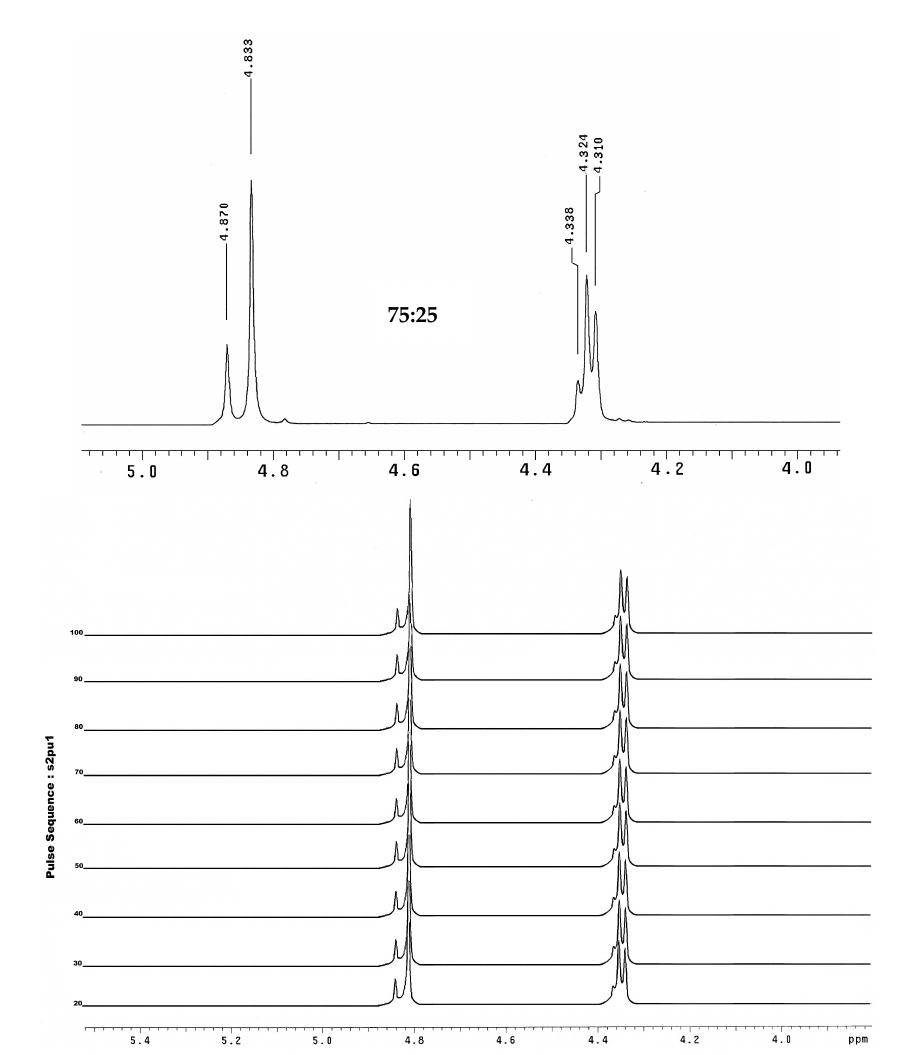
Figure 1. ( a ) 1 H-NMR spectrum for compound 1 in the region between 4 and 5 ppm and ( b ) 1 H-NMR spectra acquired at different temperature from 20 to 100 °C (400 MHz, DMSO- d 6 ).